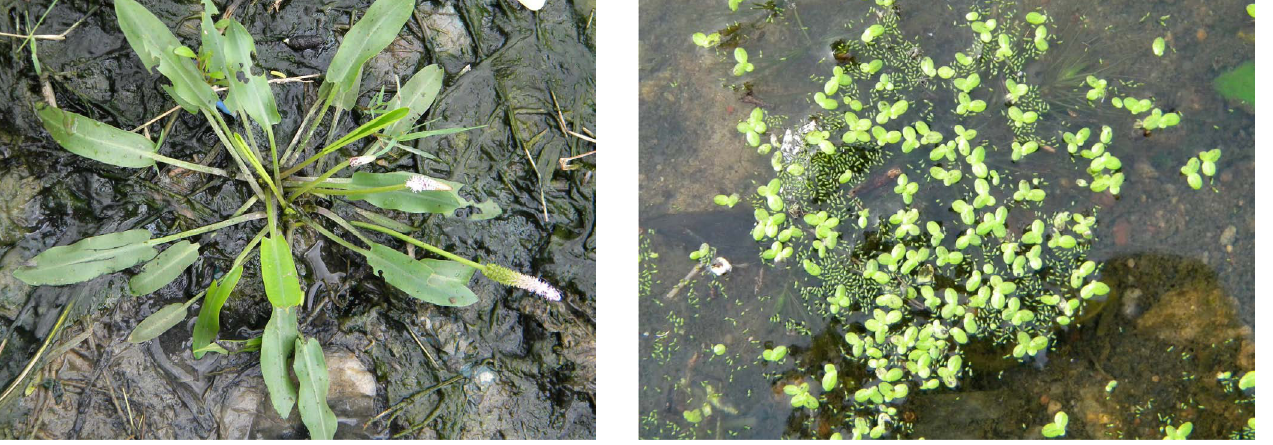
Wolffia a small, pioneer colonizer of fresh water